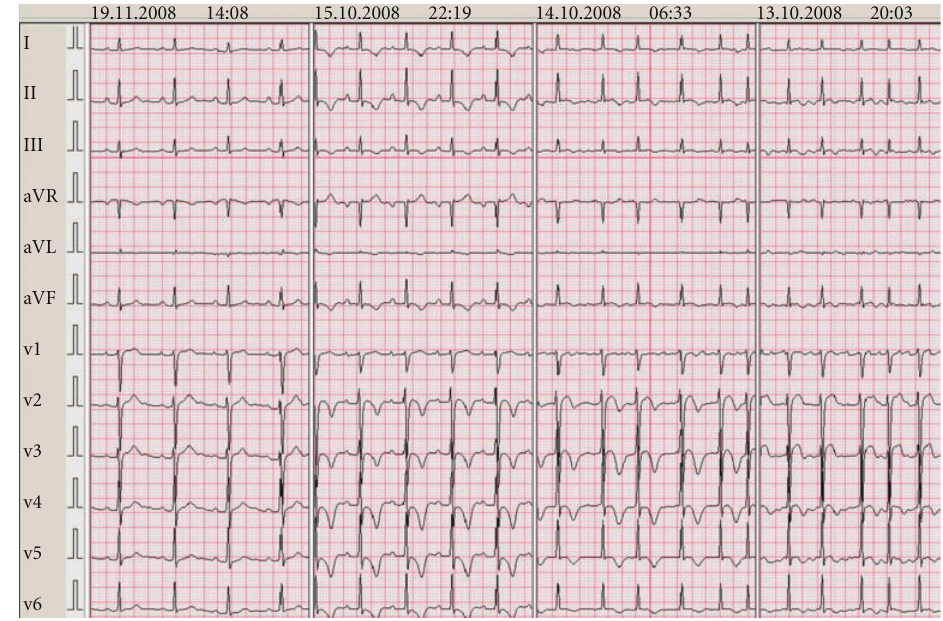
Figure 1: Case 1 (EKGs shown chronologically from right to left).